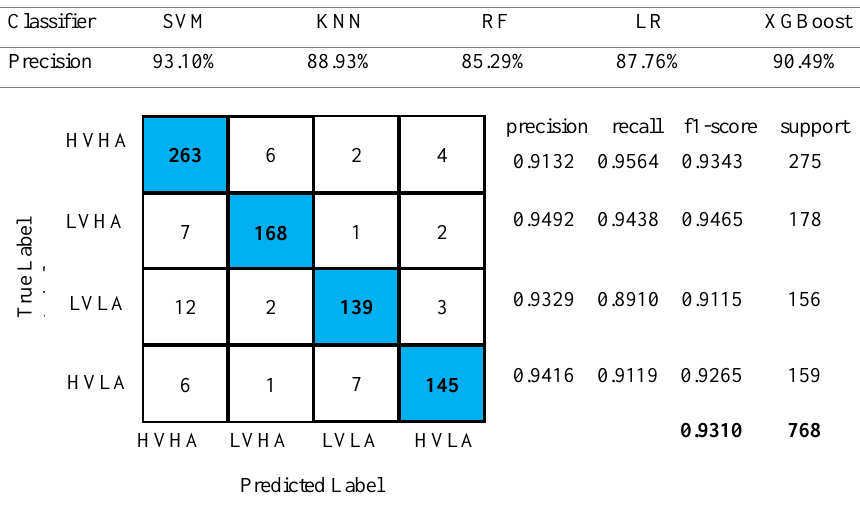
Table 1. Classification accuracy with different machine learning classifiers.